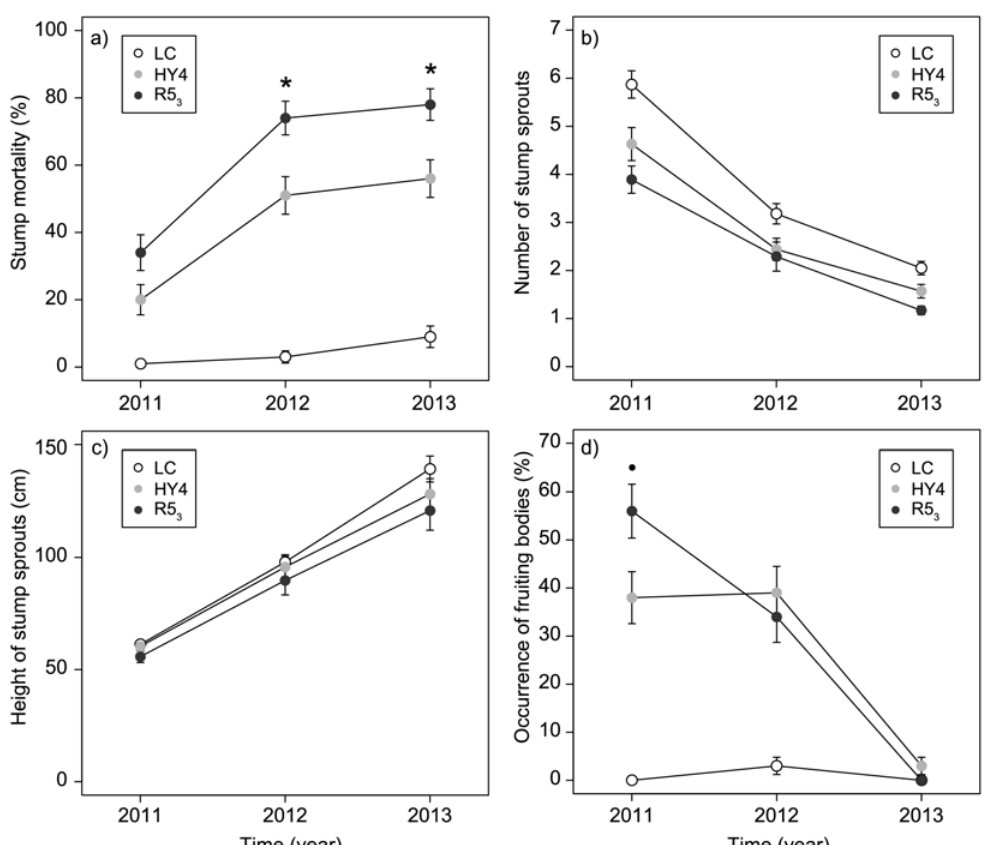
Fig 4. Comparison between the Best Progeny and Parent Strain of C . purpureum . The effects of C . purpureum strains R5 3 (a progeny), HY4 (a parental strain), and the liquid control (cutting with inoculum medium without C . purpureum ) on a) stump mortality (%), b) the number of stump sprouts (in living stumps), c) stump sprout height (in living stumps, cm), and d) the occurrence of fruiting bodies (%) on birch ( Betula pendula and B . pubescens ) stumps one, two and three growing seasons after the treatments (Phase 4). Means with standard errors are presented. Statistically significant differences ( p < 0.05) between fungal strains R5 3 and HY4 are indicated with an asterisk and indicative differences (0.05 (cid:3) p (cid:3) 0.10) with a dot. See Tables 4 – 7.